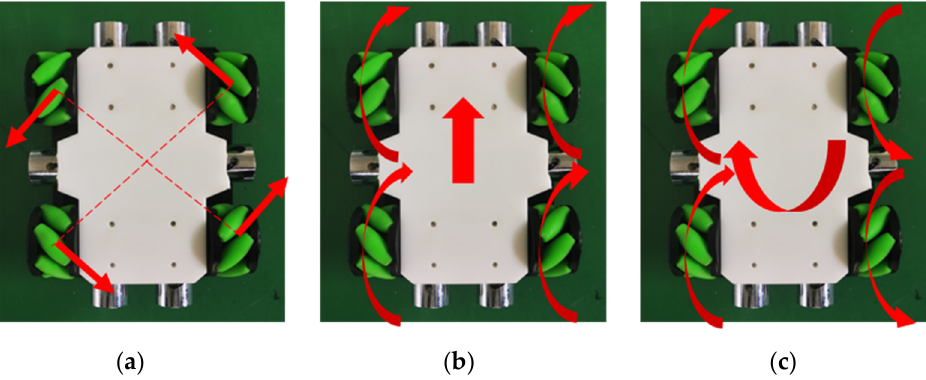
Figure 1. Mecanum wheel and layout of wheels: ( a ) Direction of rollers; ( b ) Forward movement; ( c ) Rotational movement.